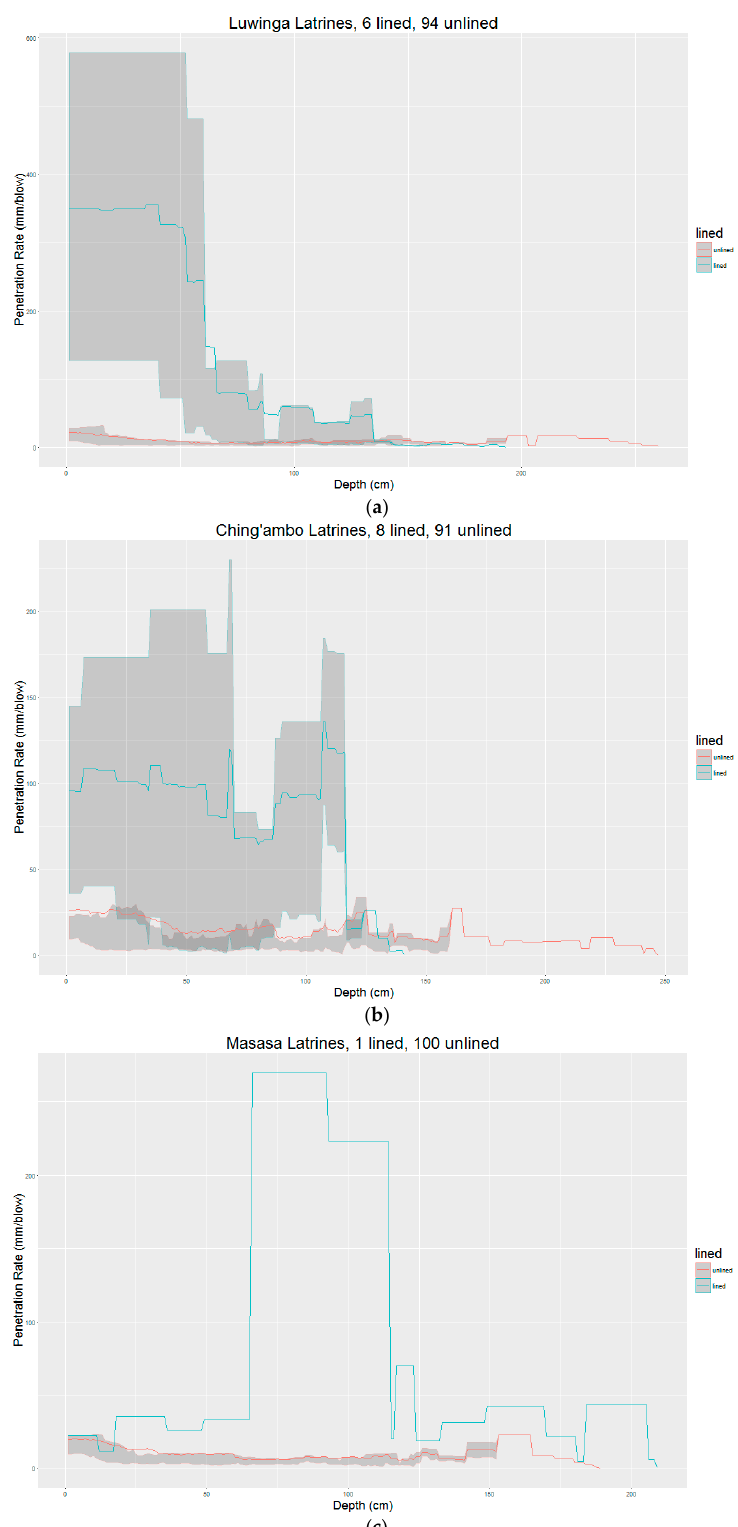
Figure 3. Average sludge strength for lined latrines and unlined latrines in areas of ( a ) Luwinga; ( b ) Ching’ambo; and ( c ) Masasa. Shading indicates 75th and 25th percentiles. ( b ) Ching’ambo; and ( c ) Masasa. Shading indicates 75th and 25th